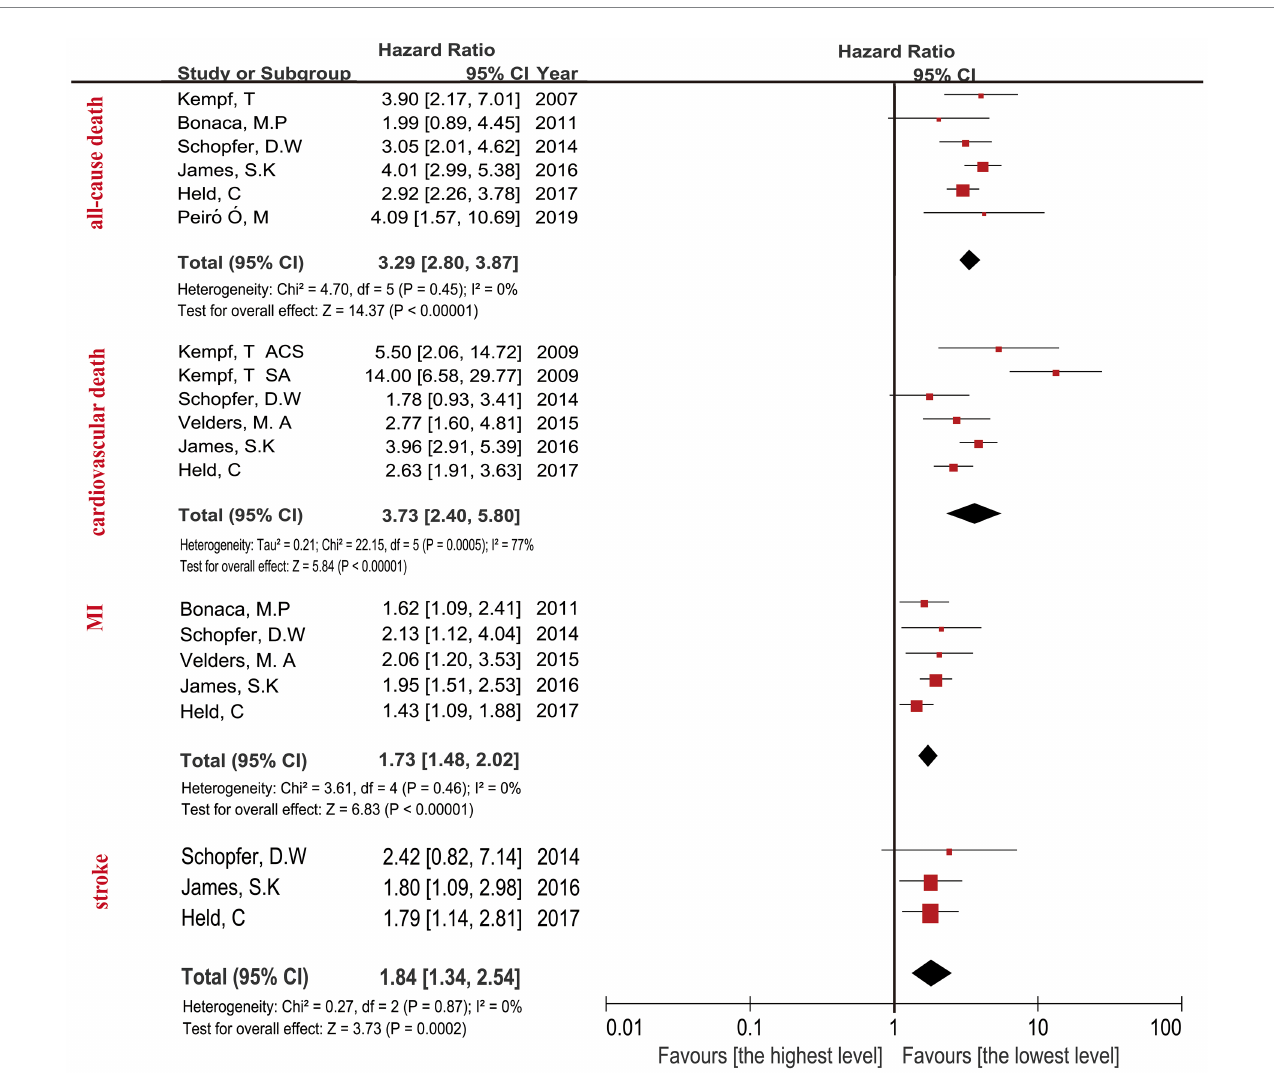
FIGURE 2 Forest plot showing the HR and 95% CI of individual cardiovascular events for studies comparing the highest and lowest concentrations of GDF-15 after adjustment clinical